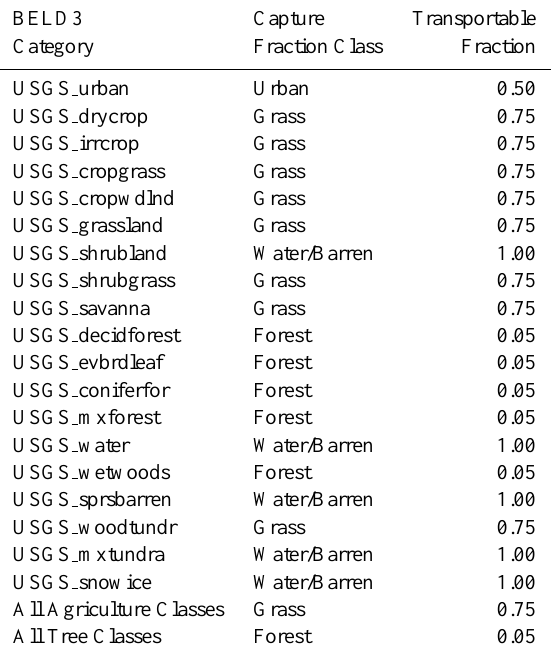
Table 1. BELD3 categories, capture fraction class, and trans- portable fraction. Transportable fraction (ranging from 0 to 1) is defined as the fraction of total emitted PM mass that becomes en- trained in the grid-cell